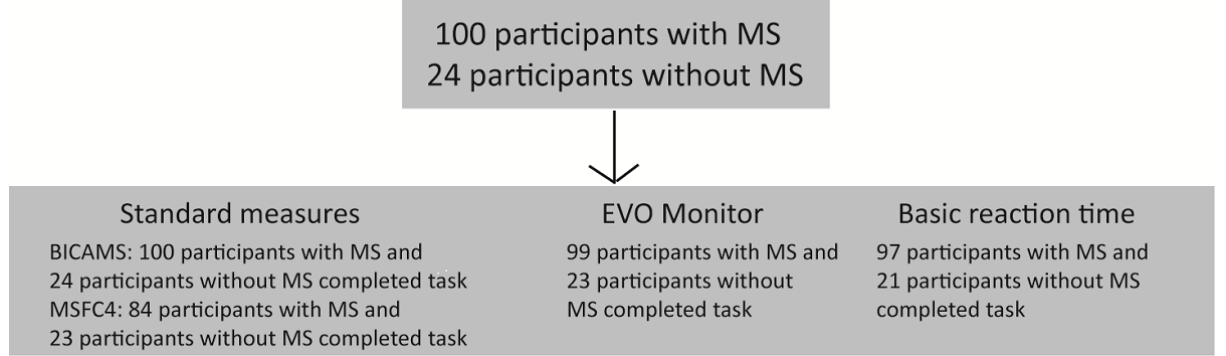
Figure 2. Study task completion rate. BICAMS: Brief International Cognitive Assessment for Multiple Sclerosis; MS: multiple sclerosis; MSFC: Multiple Sclerosis Functional